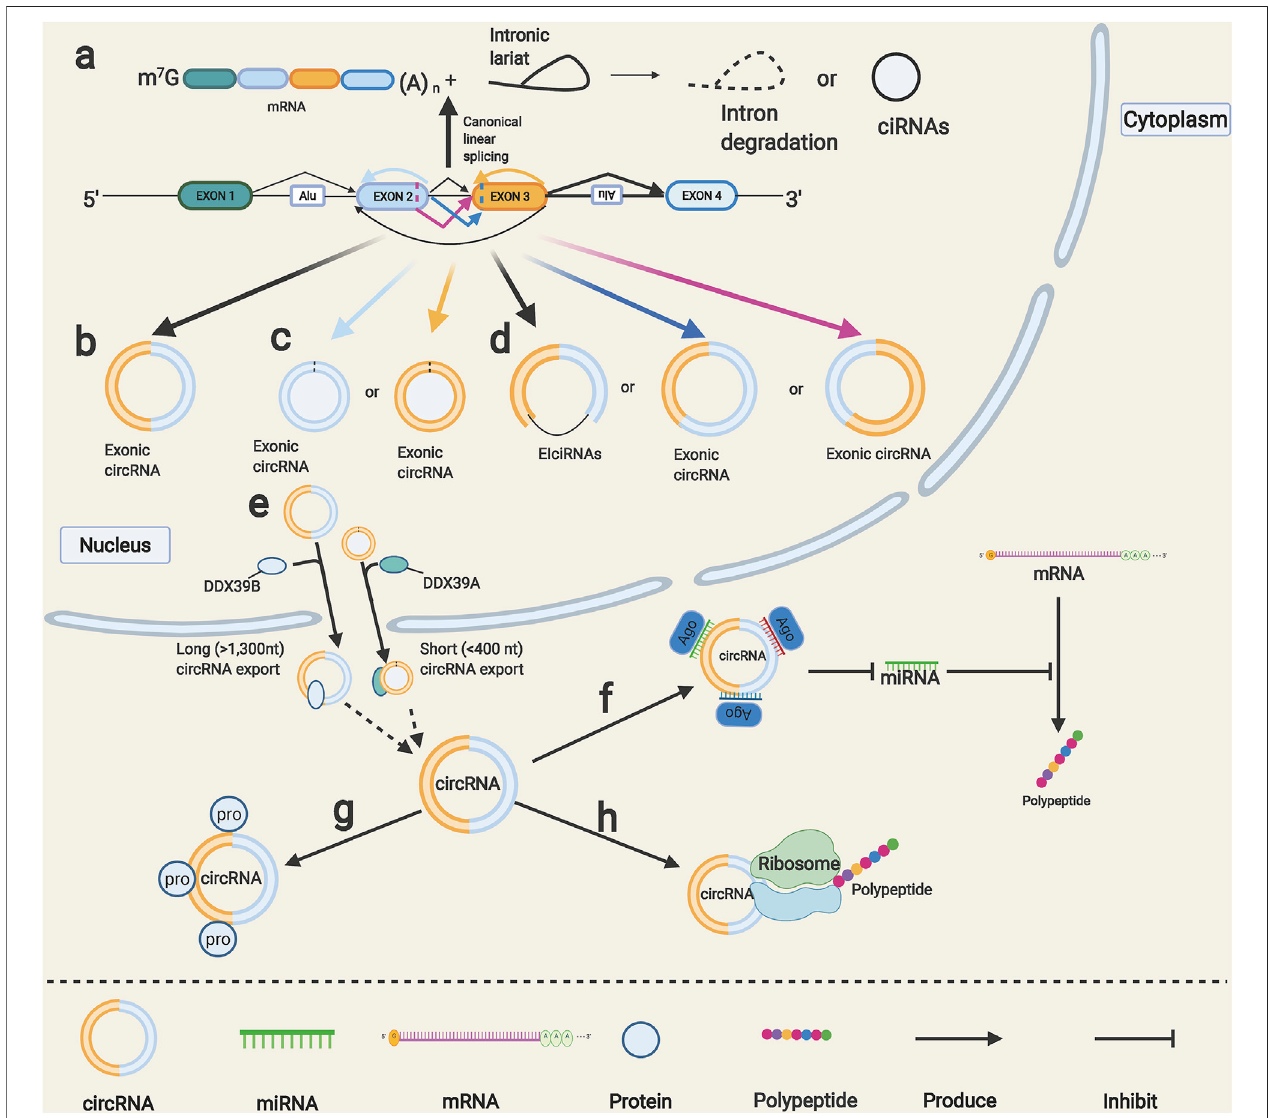
FIGURE1| FormationandfunctionsofcircRNAs. (A) CanonicallinearsplicingcanproducenormallinearmRNA (left) andintroniclariat (right) ,introniclariatrapidly degraded after splicing or escape from debranching step then generate circular intronic RNAs (ciRNAs) (right) . (B) Back-splicing of exons produces circRNAs. (C) Alternativeback-spliceyieldsdifferentsingle-exoncircRNAs. (D) AlternativesplicethathappenedwithincircRNAsproducesthreebasictypesofcircRNAs. (E) Outputof circRNAs from nucleus to cytoplasm requires unique proteins mediation. (F) CircRNAs can function as miRNA sponge to indirectly regulate miRNA downstream target genes. (G) CircRNAs can directly interact with proteins to regulate their functions. (H) CircRNAs can translate unique peptides.